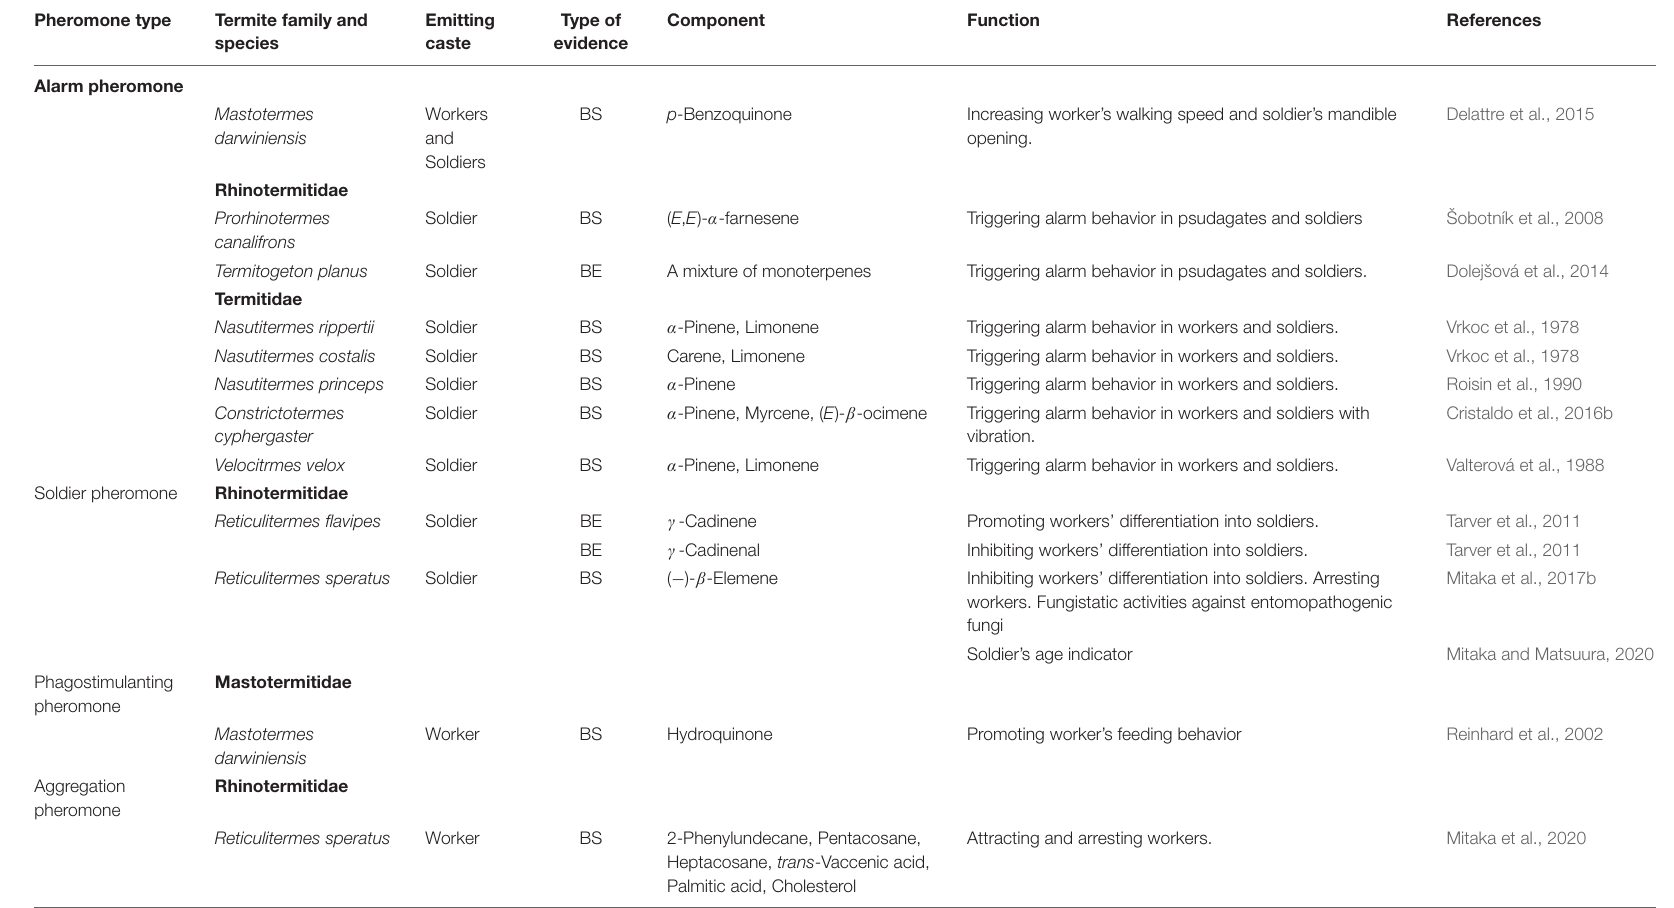
TABLE 3 | List of pheromones used by non-reproductive castes in